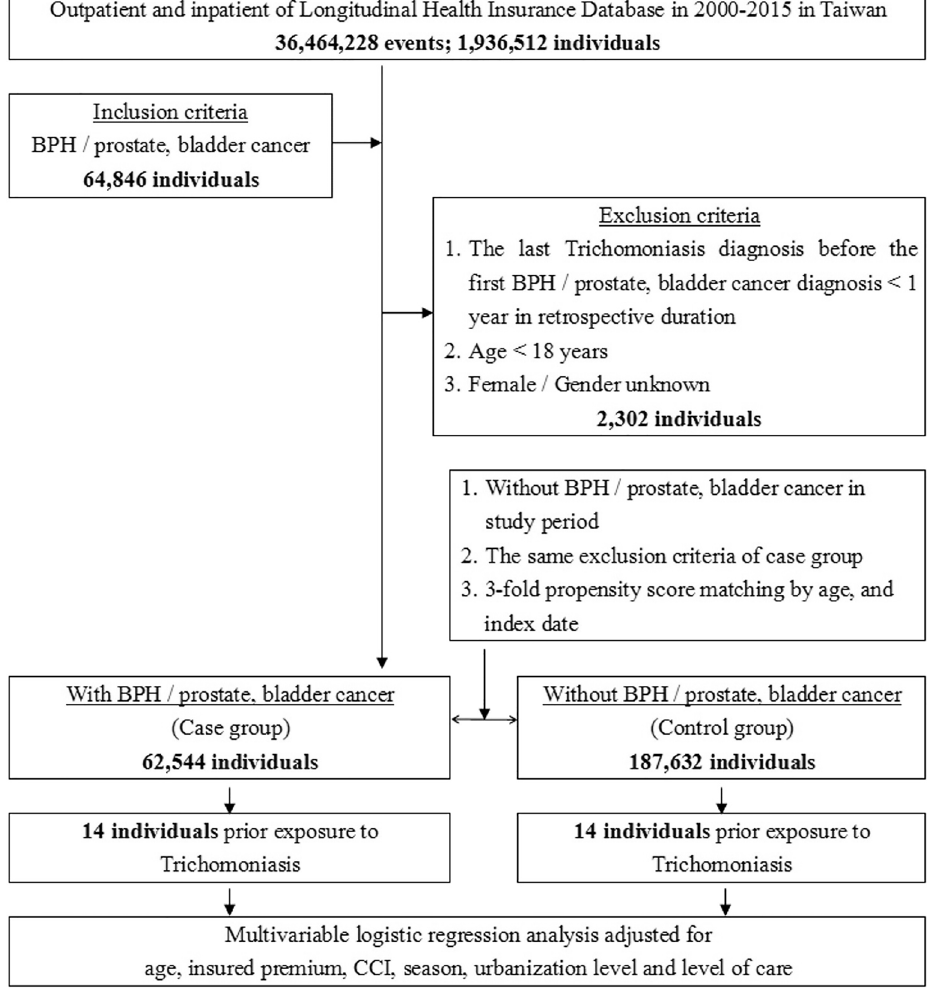
Figure 1. The flowchart of the study design (nested case–control study) from National Health Insurance Research Database in